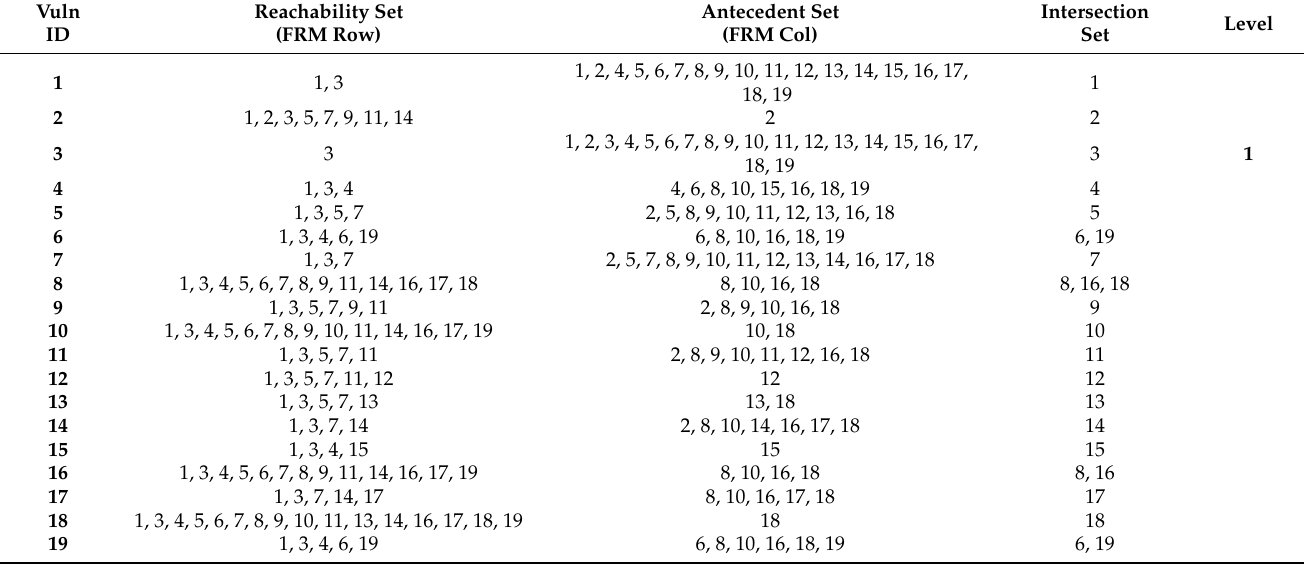
Table 4. Levelling into a